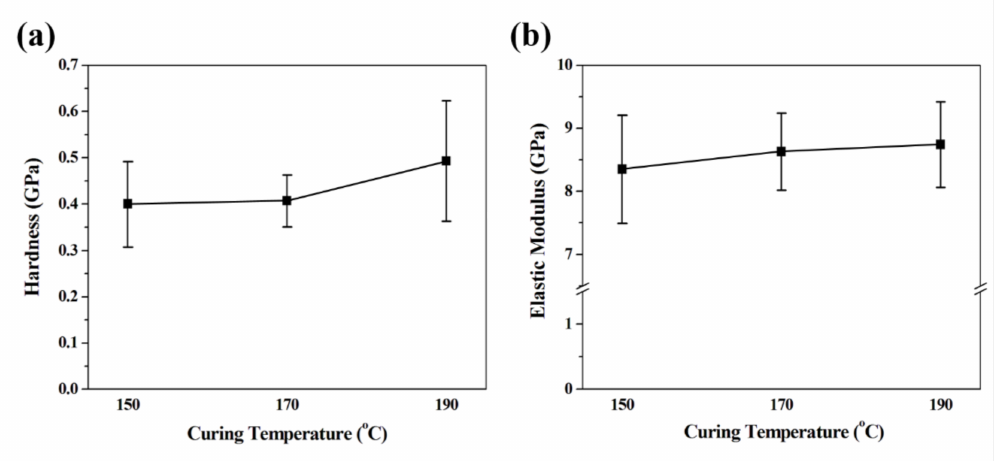
Figure 5. Nanoindentation results of the silver electrode fabricated according to di ff erent curing temperatures; ( a ) Hardness and ( b ) Elasticity